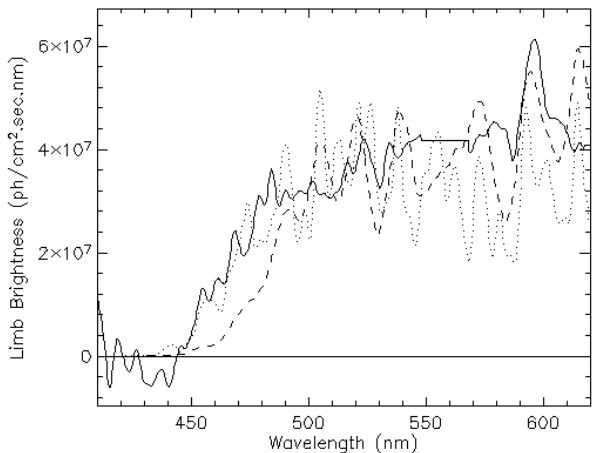
Fig. 3. Comparison between the GLO-1 observed airglow limb “continuum” (solid, from panel (C) of Fig. 2) and the NiO ∗ model spectra for laboratory pressure (dash, from Fig. 1) and for meso- spheric pressure (dot). The large noise spikes in the difference spec- trum at OI 558nm (panel (C) of Fig. 2) are replaced by a straight line.